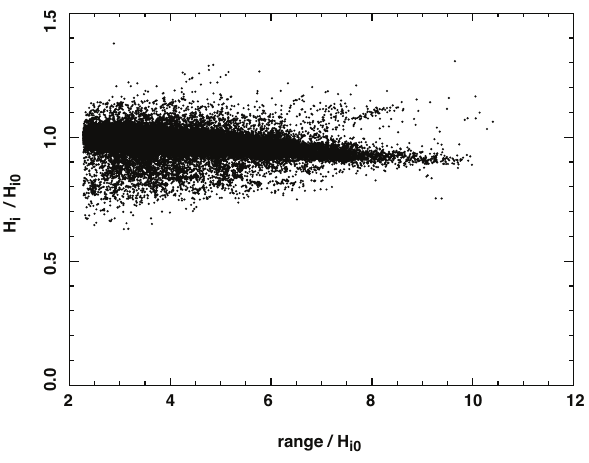
Fig. 7. Scatter-plot of dimensionless height corrected for zenith and range (first differenced from range-controlled fit, then divided by the modeled height at the appropriate zenith angle but at short range) versus radio-propagation azimuth. The solid curve is a fit to a diurnal cosine, parametrized by amplitude and phase (see